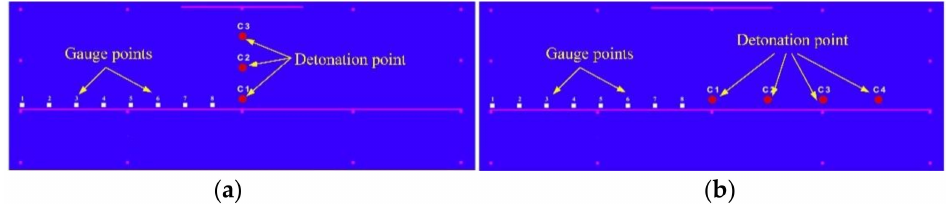
Figure 19. The arrangement of different explosive positions and gauge points. ( a ) Different height of the explosive position; ( b ) Different horizontal position of the